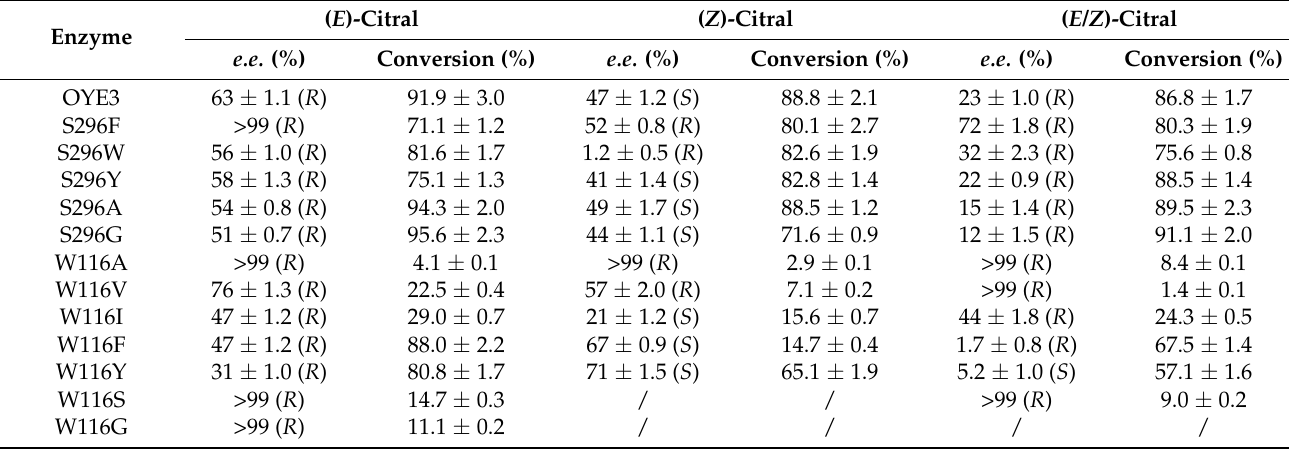
Table 2. The catalytic performances of OYE3 and its S296X and W116X variants 1 .